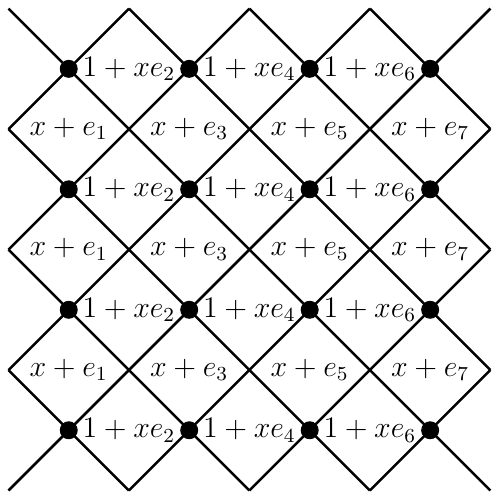
Figure 11 . The AF Potts model with free boundary conditions, described by the graphical expan- sion of the transfer matrix